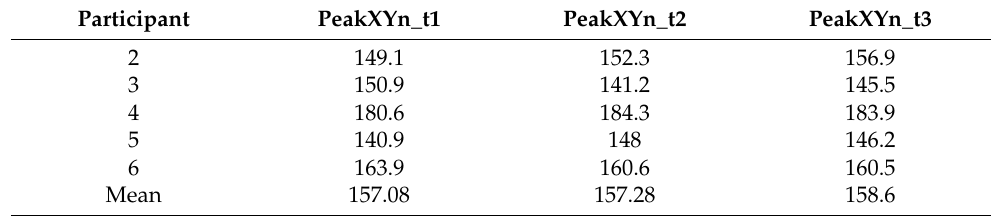
Table 24. PeakXY, nectar 10 mL (%C2–4) individual and mean measurements at three assessment time points.